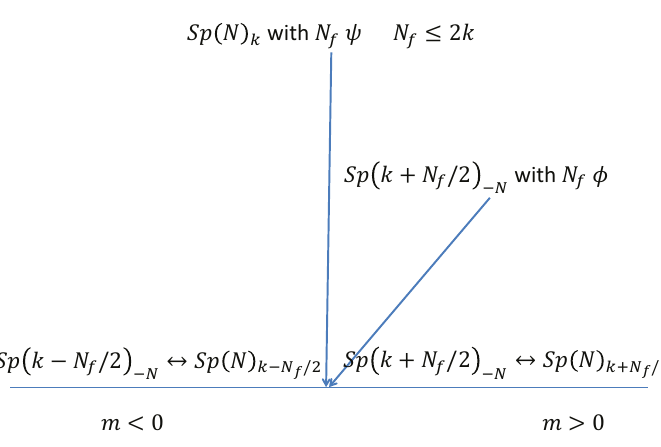
Figure 5 . The phase diagram of Sp( N ) k for N f (cid:20) 2 k .